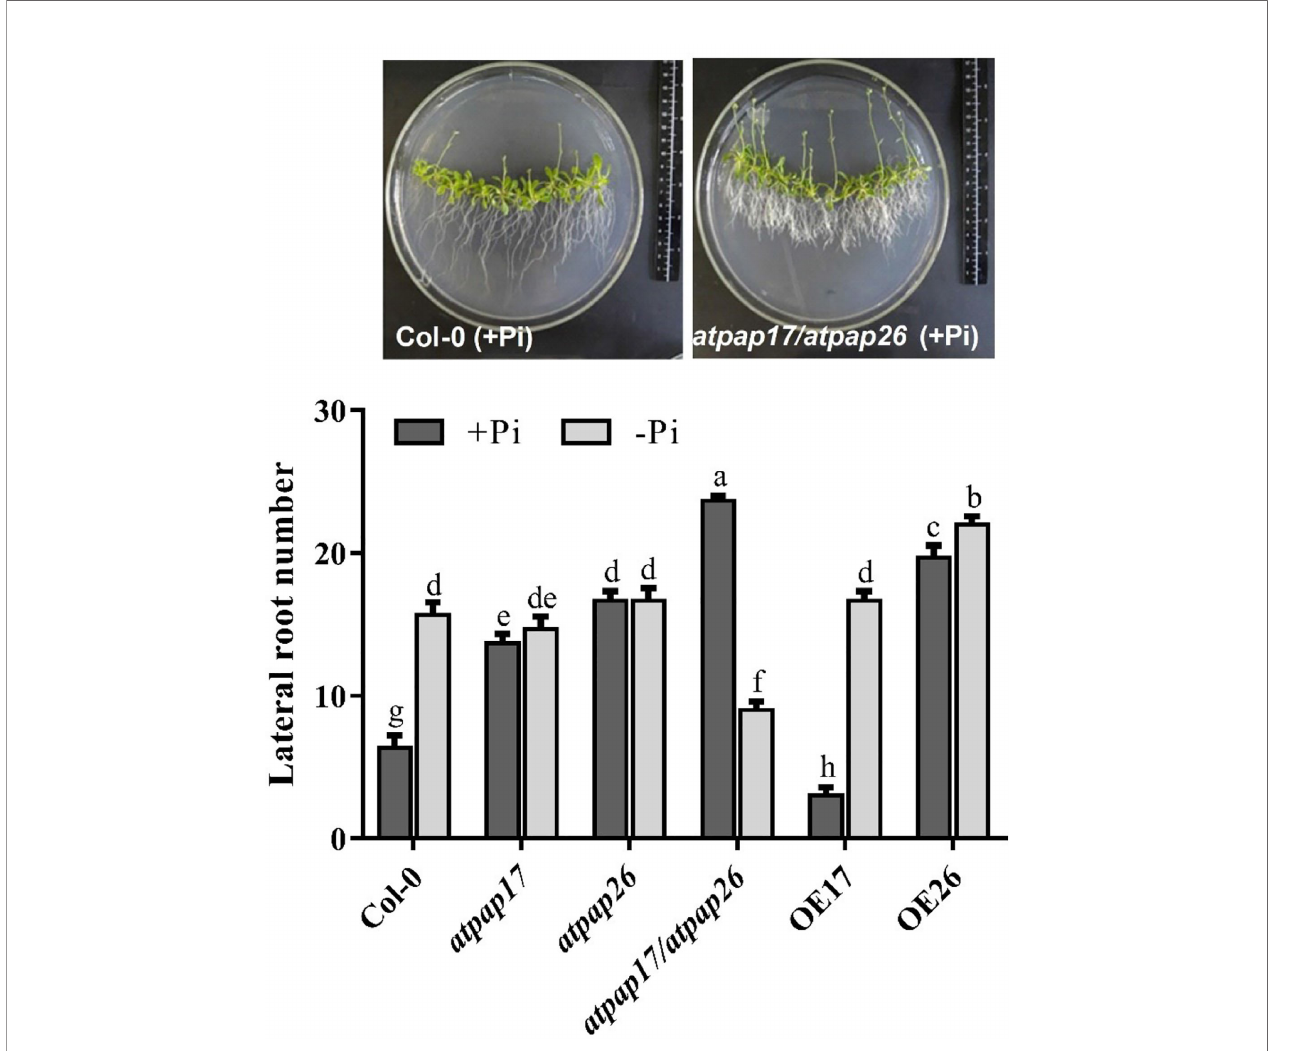
FIGURE 9 | Lateral roots number of Col-0, AtPAP17 and AtPAP26 mutants ( atpap17 , atpap26 , and atpap17/atpap26 ) and overexpressing lines (OE17 and OE26) (each overexpressed line includes four independent transgenic lines) grown under +Pi (1.25 mM KH 2 PO 4 ) and − Pi (no Pi) conditions. All lines were grown for 21 days on vertically oriented MS agar plates as described in the Materials and Methods . Values are the means ± SE of three biological replicates and each replicate is the mean of 12 seedlings. Signi fi cant differences are indicated by different letters above the bars ( P <